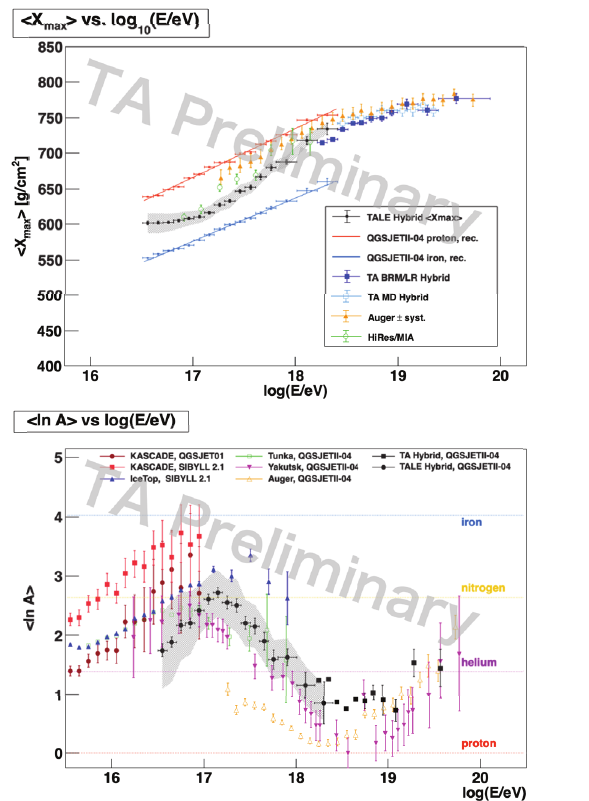
Figure 5: Top: Comparison of (cid:6) X max (cid:7) as a function of shower energy with Auger [6], TA [7, 8], HiRes / MIA [9] measurements. Bottom: Comparison of (cid:6) ln A (cid:7) as a function of energy with various measurements. For com- parison, two interpretations by KASCADE [10], IceTop [11], Tunka [12], Yakutsk [13], Auger [6], and 8.5 yrs TA BRM / LR hybrid [7] results are shown. The gray band in both figures represents the systematic uncertainty on X max measurement.